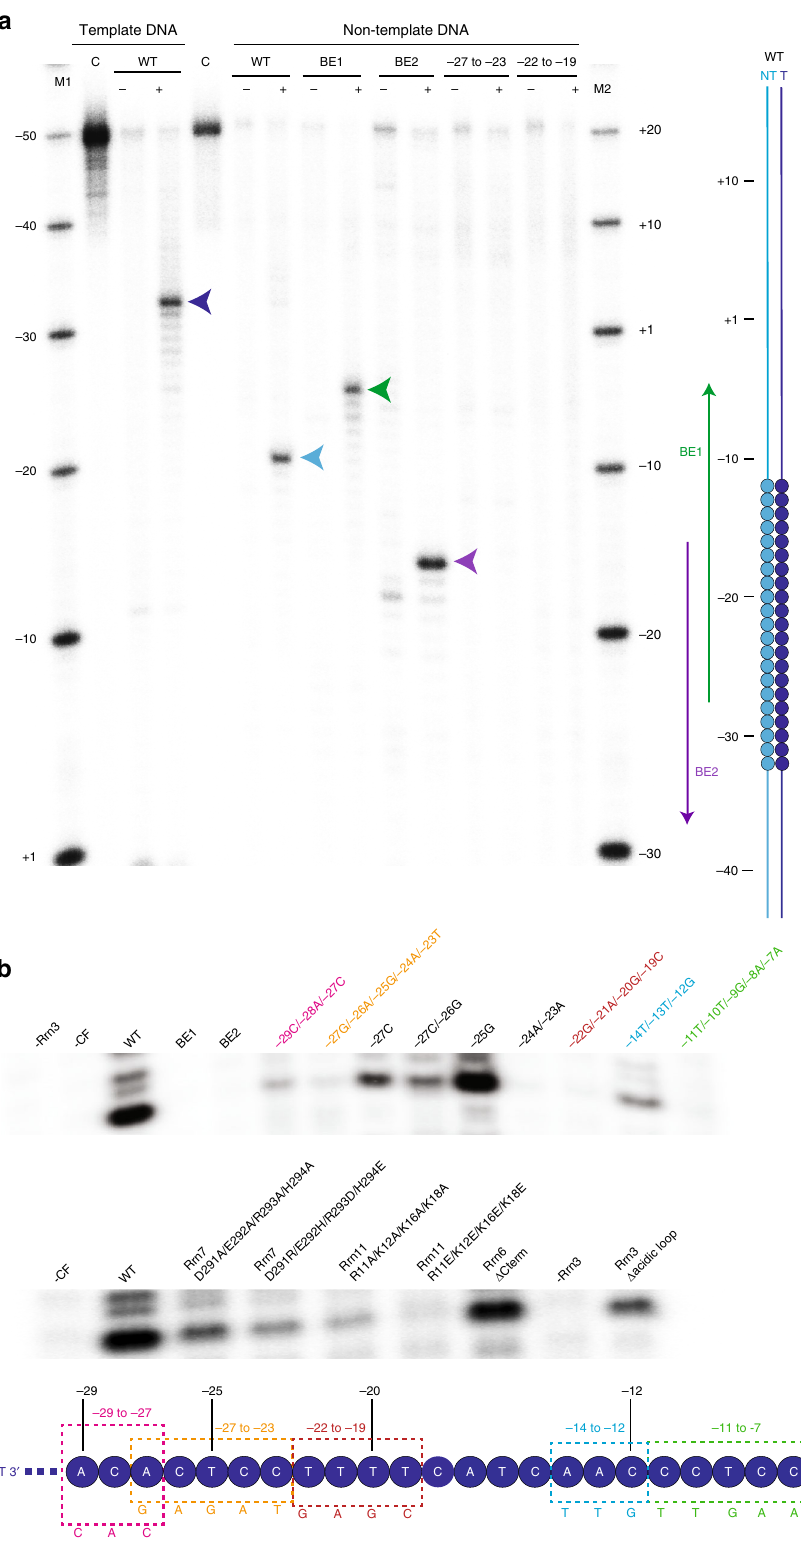
dsDNA through interactions with the clamp coiled-coil. The rota- tion of CF-upstream DNA with respect to Pol I-Rrn3 results in formation of the Pol I CC2 (Fig. 6b). Interactions between Rrn3, Pol I and CF are mediated through an 80-residue acidic loop in Rrn3 that fastens the Zn-ribbon of Rrn7 onto Pol I. Interestingly, the Pol